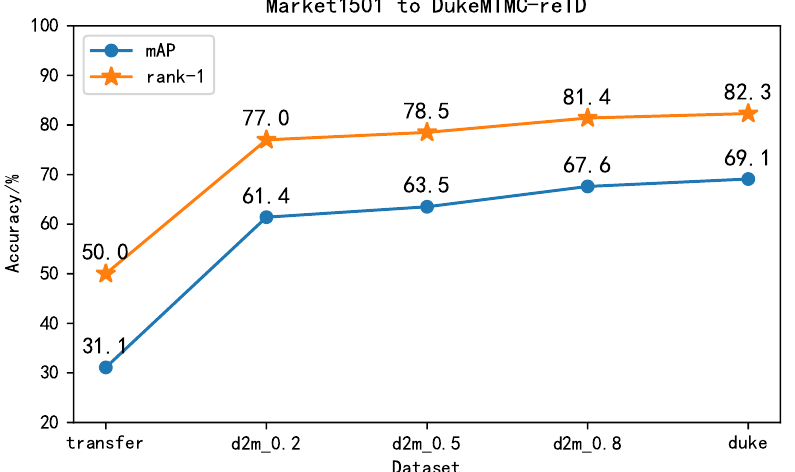
Figure 8. The results of ablation experiments for Market1501 to DukeMTMC-reID